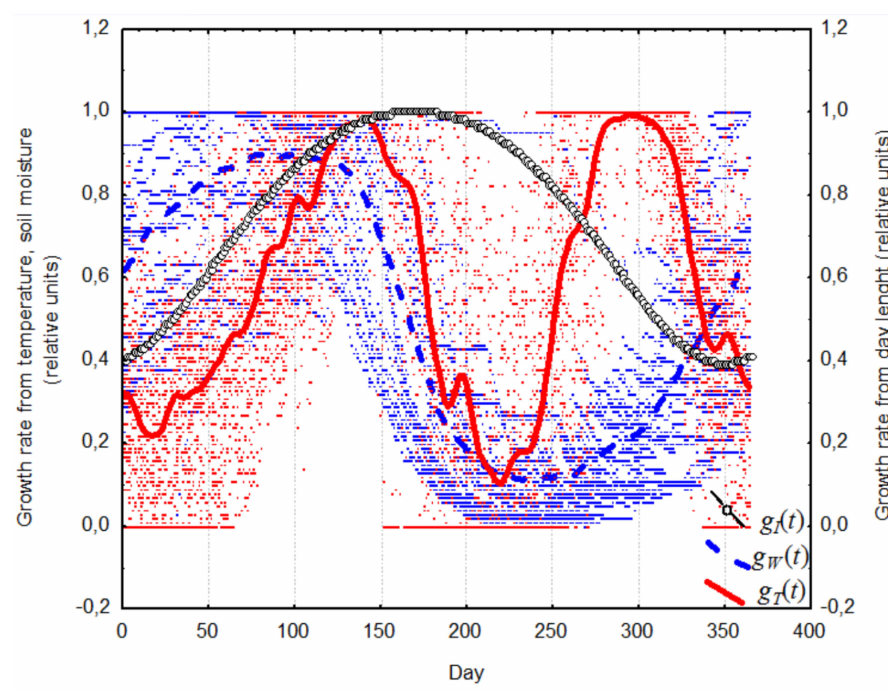
Fig. 3. Partial growth rates depending on day length g I (t) (black circles), soil moisture g W (t) (blue line) and temperature g T (t) (red line) for 1982-2004 fitted by negative exponentially-weighted smoothing (Mclain, 1974) 2 . Blue and red dots on the graph are daily values of partial rates superimposed on each other for each year.